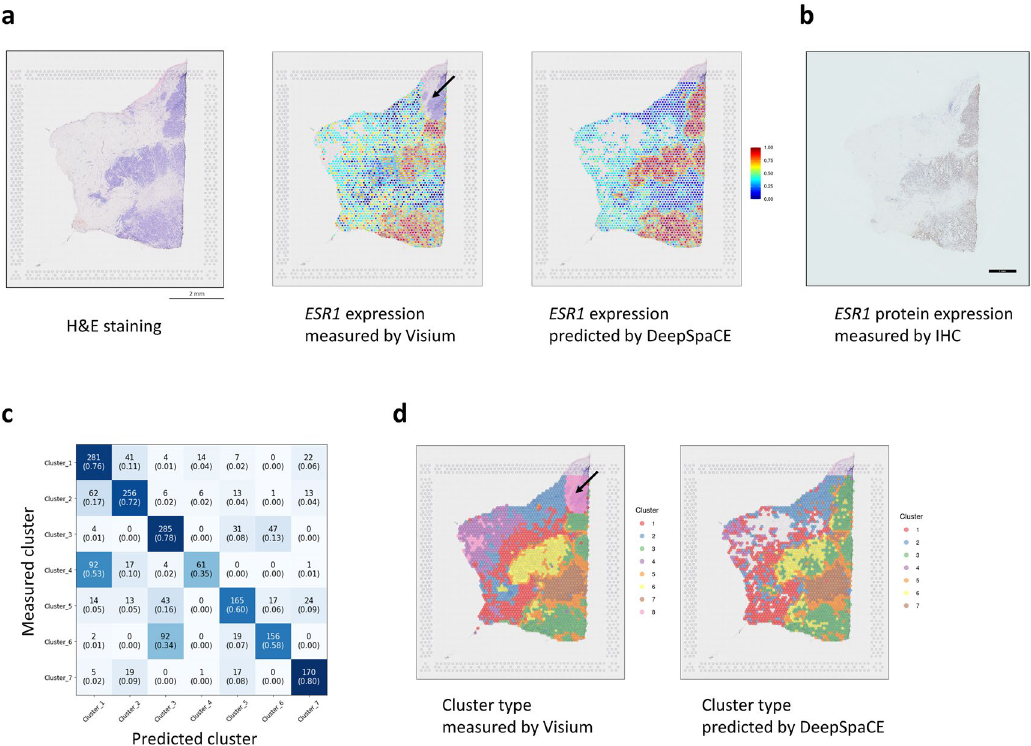
Figure 2. DeepSpaCE predicts spatial gene expression and cluster types. ( a ) Left image shows section D2 after hematoxylin and eosin (H&E) staining. Middle image shows a heatmap of normalized ESR1 expression in section D2, measured using the 10x Genomics Visium platform. ESR1 expression in the upper right region (black arrow) of section D2 could not be measured because of potential permeabilization errors. Right image shows the heatmap of ESR1 expression in section D2, predicted by DeepSpaCE. The blank areas represent spots excluded because of a small amount of information. ( b ) Image showing immunohistochemical staining of ESR1 protein in the adjacent section of section D2. ( c ) Heatmap shows the confusion matrix of the measured and predicted cluster types. The number in each box is the number of labels, and the number inside each pair of parentheses is the recall value. ( d ) Left image shows a heatmap of transcriptomic cluster types in section D2, as measured using the Visium platform. The cluster types in the upper right region (black arrow) of section D2 were not determined because of potential permeabilization errors. Right image shows the heatmap of cluster types in section D2, predicted by DeepSpaCE. Blank areas represent spots that were excluded because of low information. For training and gene prediction parts, we excluded cluster 8 because most of the region belonging to the cluster showed potential permeabilization